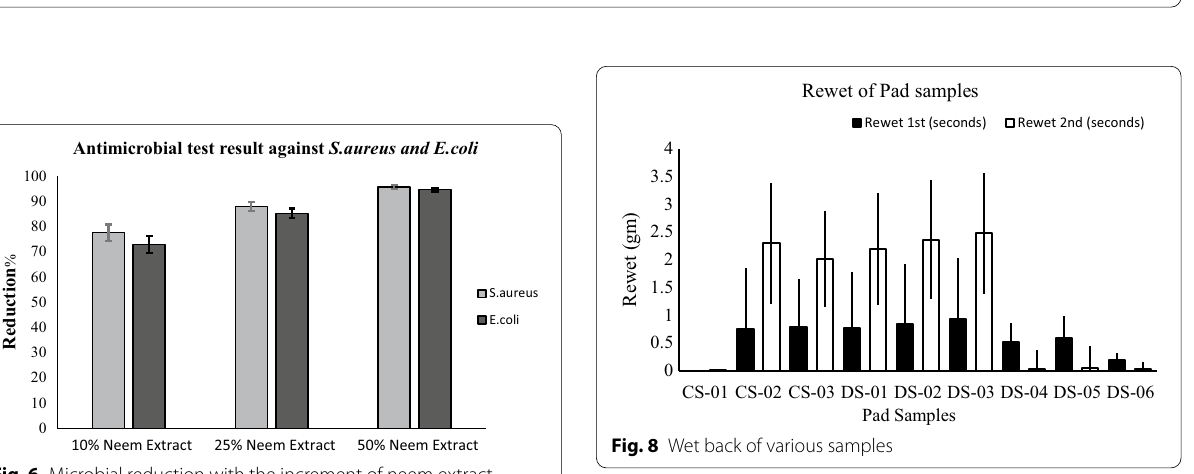
Fig. 5 Number of surviving cells ( E. coli ) after contact with untreated non-woven fabric sample ( a ) and non-woven fabric sample treated with 50% neem extract solution ( b )